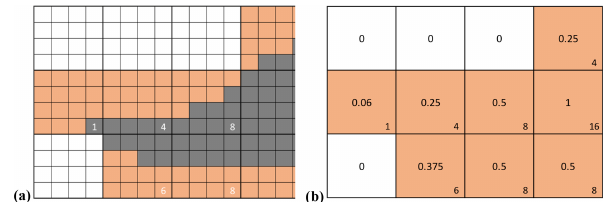
Figure D2. Schematic of the sub-grid implementation to translate the retreat mask defined on a high-resolution observational grid (a) to the coarser resolution (b) of an ice sheet model.